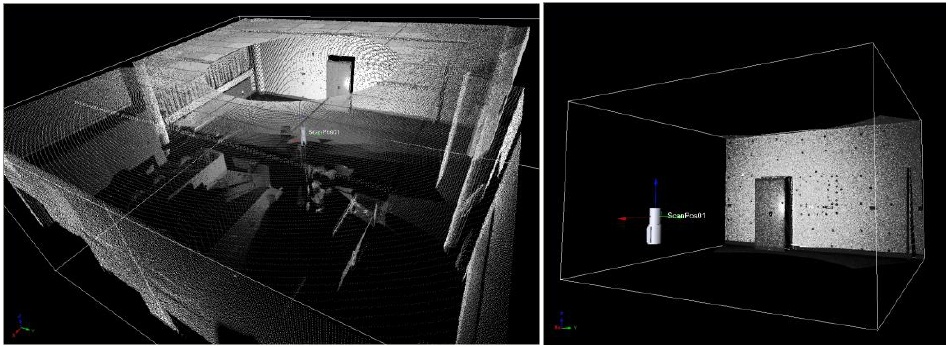
Figure 3. The room with the targets in the case study.